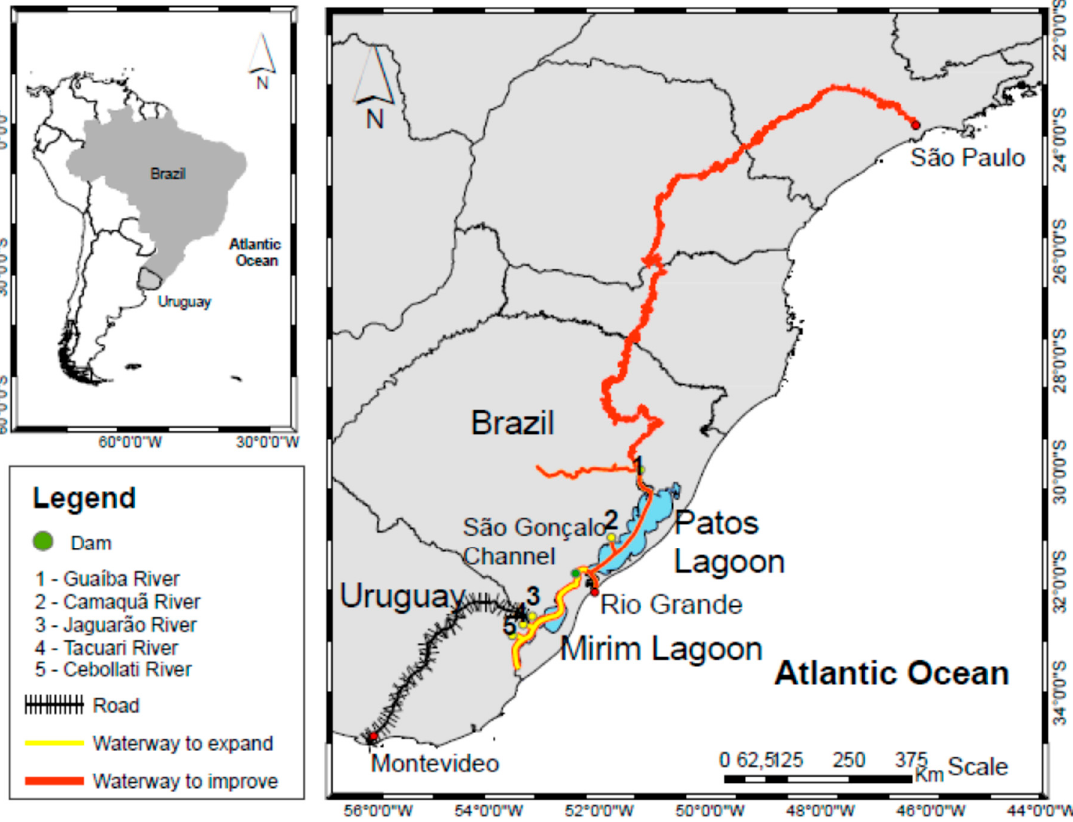
Figure 1. The Patos-Mirim system location. The yellow/orange solid line indicates the São Gonçalo channel and Mirim lagoon navigation project waterway. A green dot indicates the São Gonçalo dam. The yellow circles represent the most important river inputs. The red line represents the projected waterway, which involves shipping activities from Brazil and Uruguay.